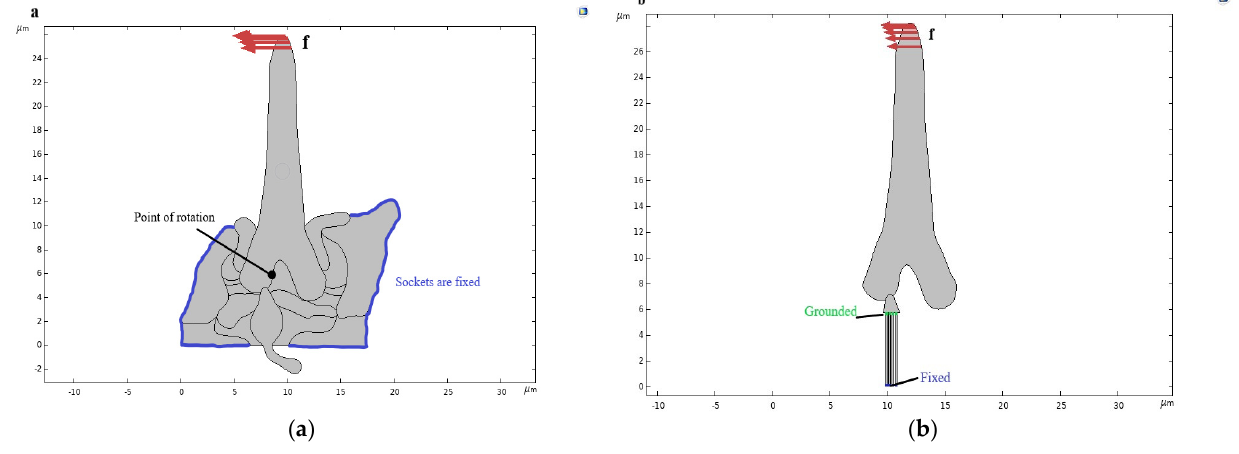
Figure 5. Scheme of the trichoid sensilla model developed from AMIRA sectional view. ( a ) Boundary condition as the socket was fixed (shown in blue color) and external load f d applied on the trichoid sensilla hair shaft. The black point is the point of rotation. ( b ) The scheme of the sensilla with the dendritic sheath and the microtubules, which are fixed at its base and grounded at the dendrite sheath (distal end of the microtubules).